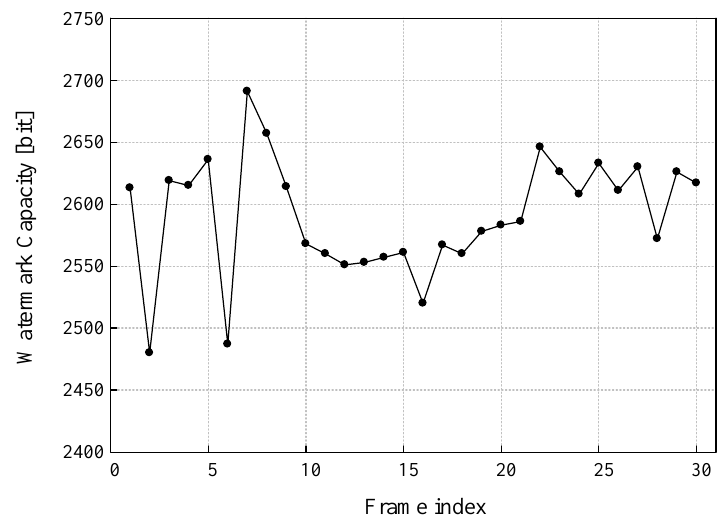
Figure 6. Average watermark capacity for 30 frames of test video sequence.